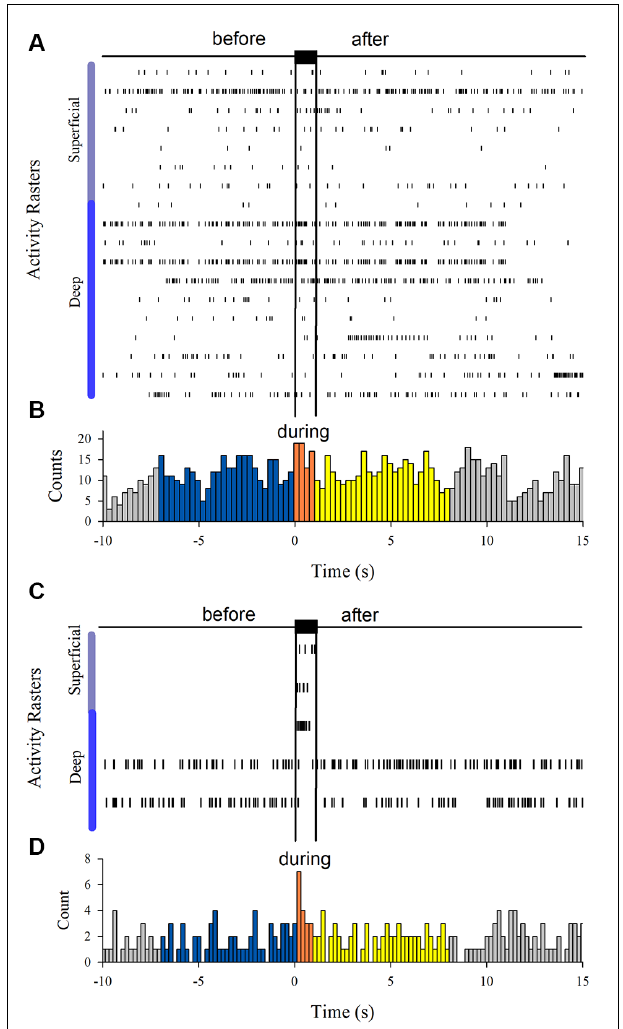
FIGURE 6 | (A) Spiking activity of neurons not responding during the vibratory stimuli ( n = 18). (C) Spiking activity of other neurons that only were excited ( n = 3) or inhibited ( n = 2) by the vibratory stimuli. (B,D) Histograms obtained from the raster displays in (A,C)